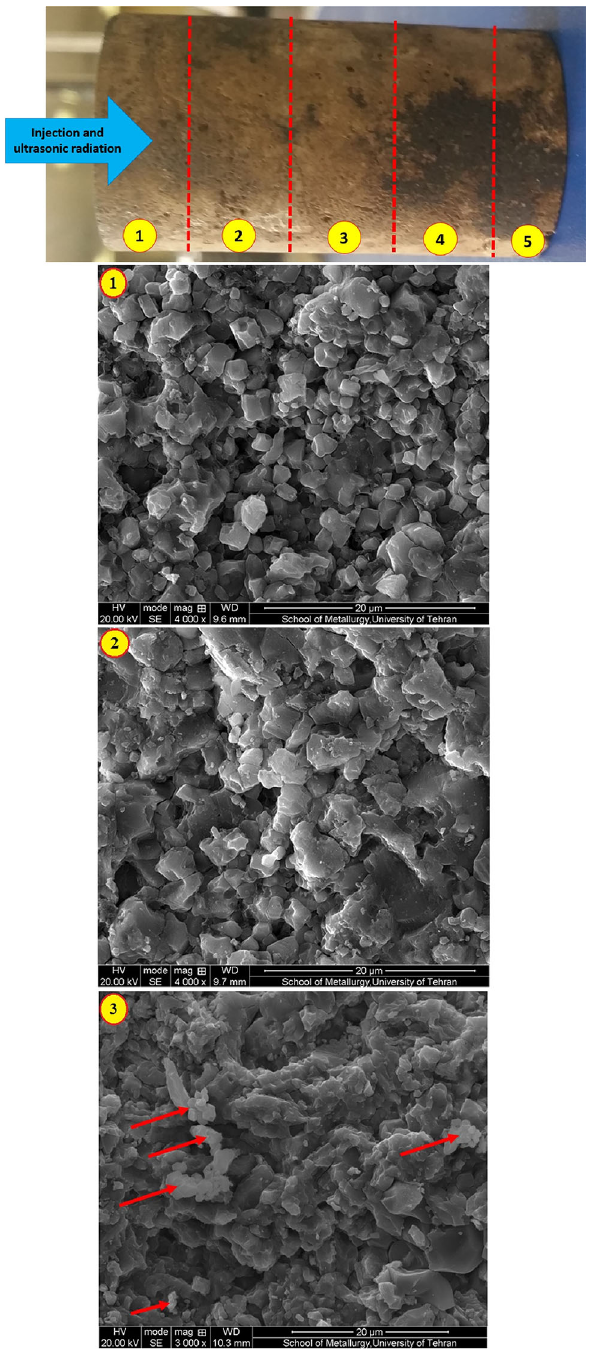
Fig. 9 SEM of thin sections of core from the near to the distant of ultrasonic